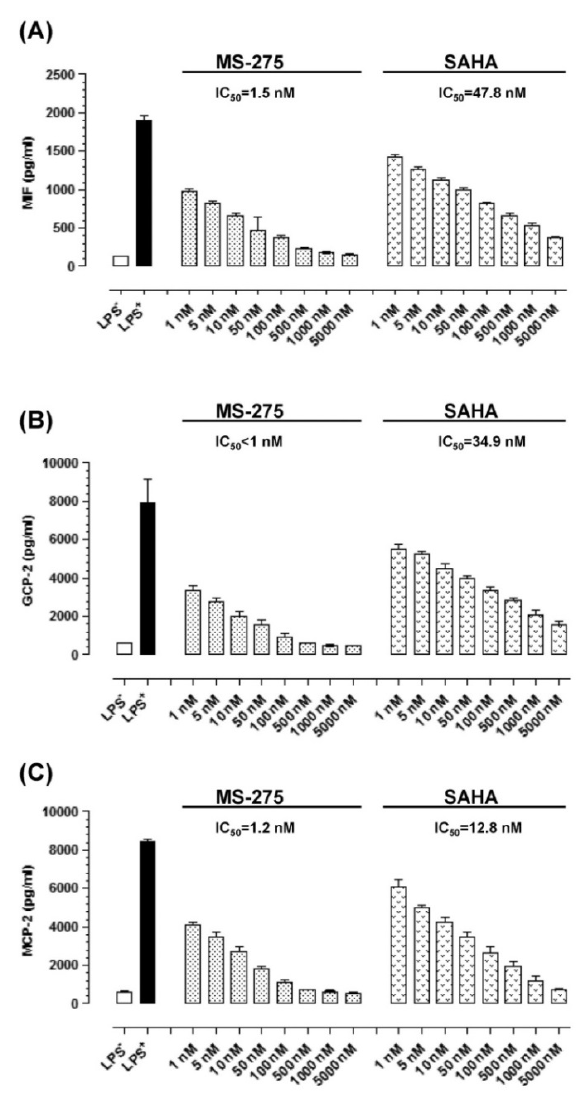
than 2 nM and those of SAHA were less than 50 nM. These IC levels required to inhibit proliferation, NF- κ B activation, and NO, IL-18 as well as VEGF secretion in E11 cells [11]. Figure 2. MS-275 and SAHA suppressed the secretion of GCP-2, MCP-2 and MIF in E11 cells. ( A ) GCP suppression. ( B ) MCP-2 suppression. ( C ) MIF suppression. E11 cells were incubated with HDAC inhibitors at various concentrations for 1 h before they were stimulated by LPS. 24 h later, the secretion of GCP-2, MCP-2 and MIF were quantified by ELISA (n = 8). Bars show the mean and SD in ( A – C